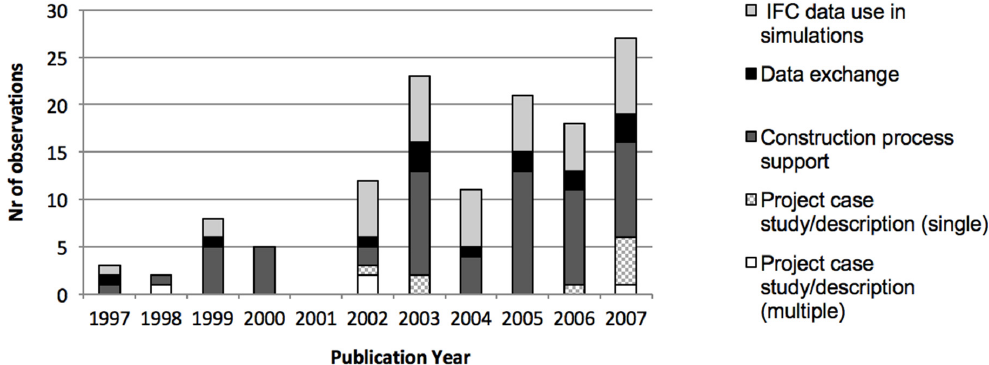
Figure 4. Applied Research: Evaluating the quality and usability of the IFC standard.